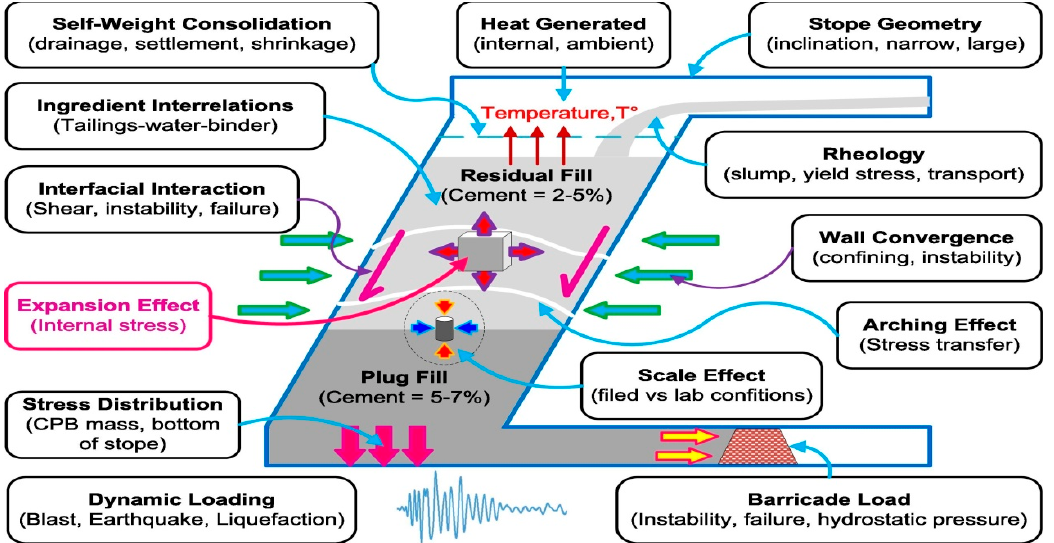
Figure 15. Internal and external factors affecting the strength of cemented sulfur tailings backfill [30].